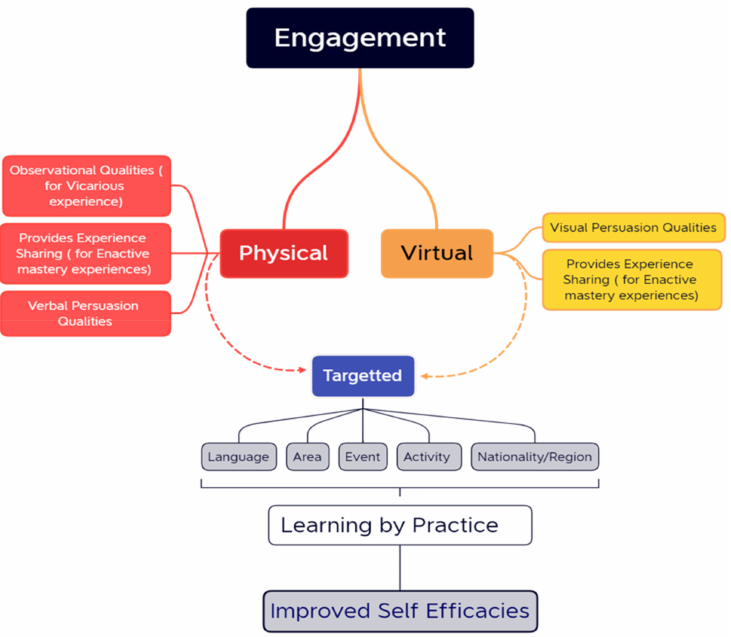
Figure 11. Proposed framework of efficacy